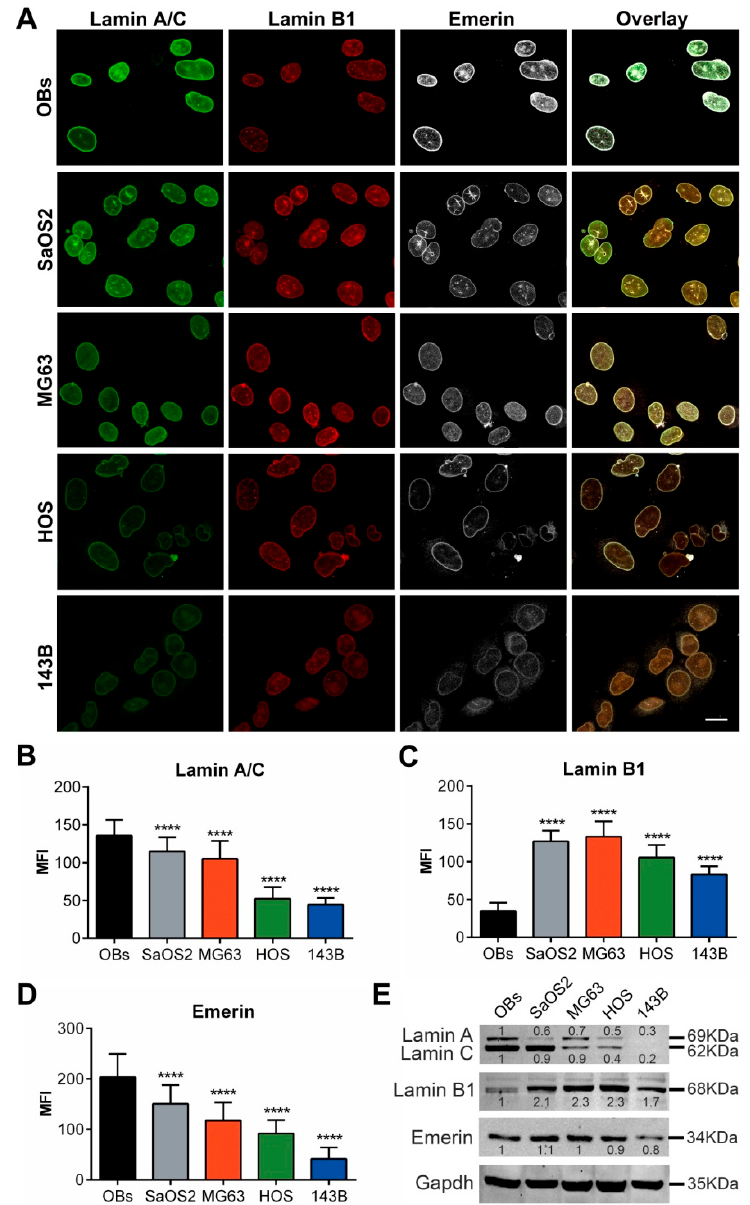
Figure 7. Main features of A / C and B1 lamins and emerin stained nuclei in osteoblasts and osteosarcoma cell lines. ( A ) Representative confocal images showing the di ff erential expression of A / C and B1 lamins and emerin associated to their nucleoskeleton dysmorphisms. Bar: 20 µ m. Mean Fluorescence Intensity (MFI) of lamin A / C ( B ), lamin B1 ( C ) and emerin ( D ) in OBs and osteosarcoma cell lines. **** p < 0.001. ( E ) Western blot analysis of lamin A, lamin C, lamin B1 and emerin in OBs and osteosarcoma cell lines, normalized versus the housekeeping Gapdh. The quantification of the bands for each protein is expressed as modulation with respect to normal